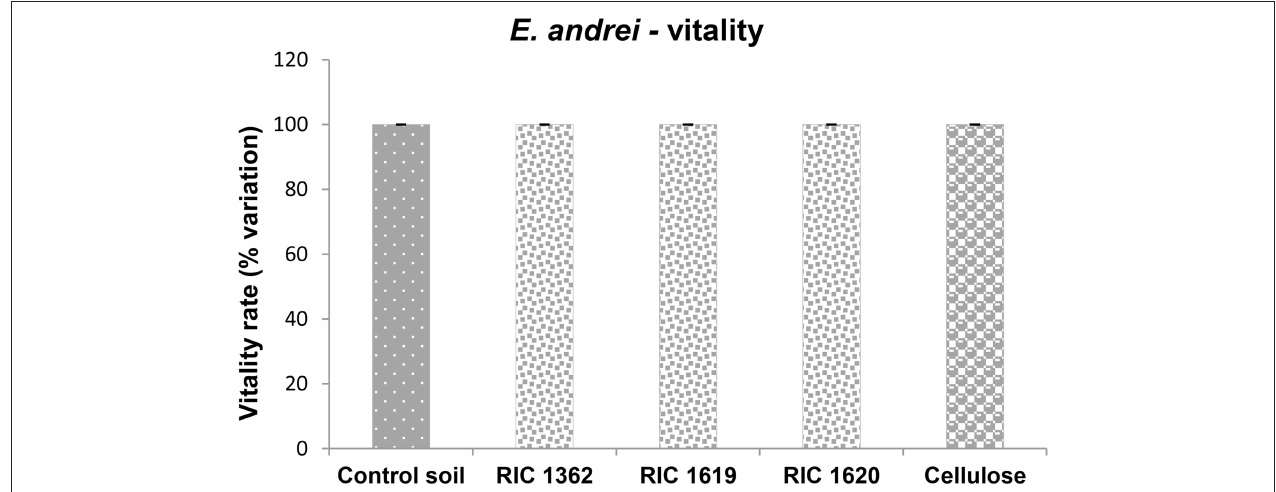
FIGURE 7 | Effects on vitality of the oligochaete E. andrei exposed to the soil samples. Data are expressed as % variation and represent the mean ± SD of at least three replicates. *Indicates statistically significant differences with respect to control values ( p < 0.05 Mann–Whitney U -test). RIC 1362, RIC 1619, RIC 1620, Mater-Bi soils; Cellulose, soil containing cellulose reference